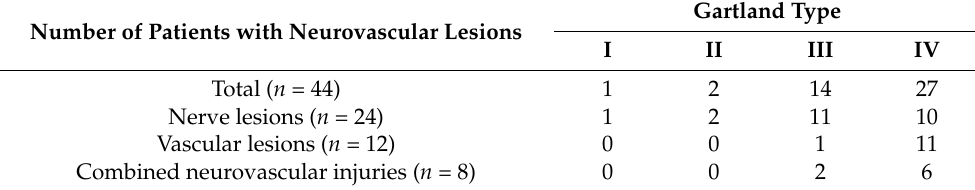
Table 5. Number of patients with neurovascular lesions per Gartland type.